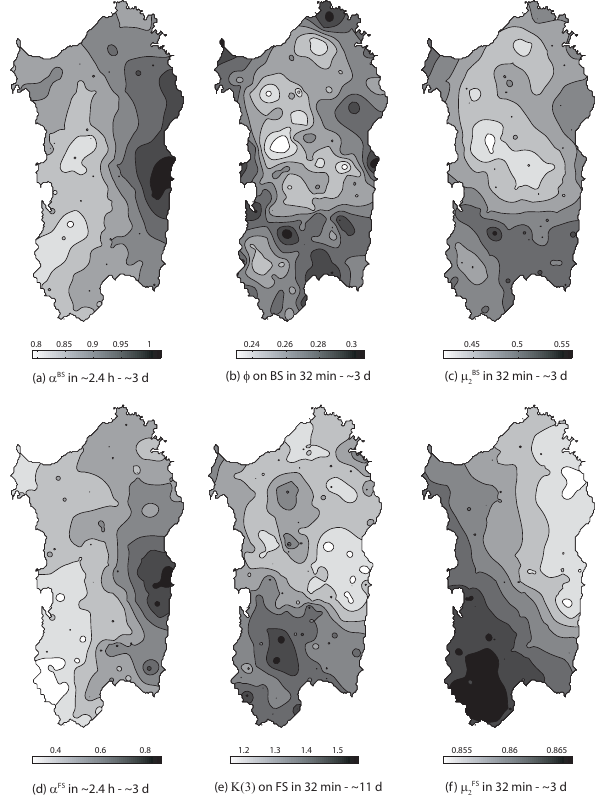
Fig. 7. Spatial maps of the metrics in the range of frontal systems, obtained by (i) applying the kriging technique for the 201 gauges in a regular grid of 1km (a power model has been fitted to the em- pirical variogram), and (ii) drawing the contour lines from the grid. Top (bottom) panels report results for the metrics applied to BS (FS)